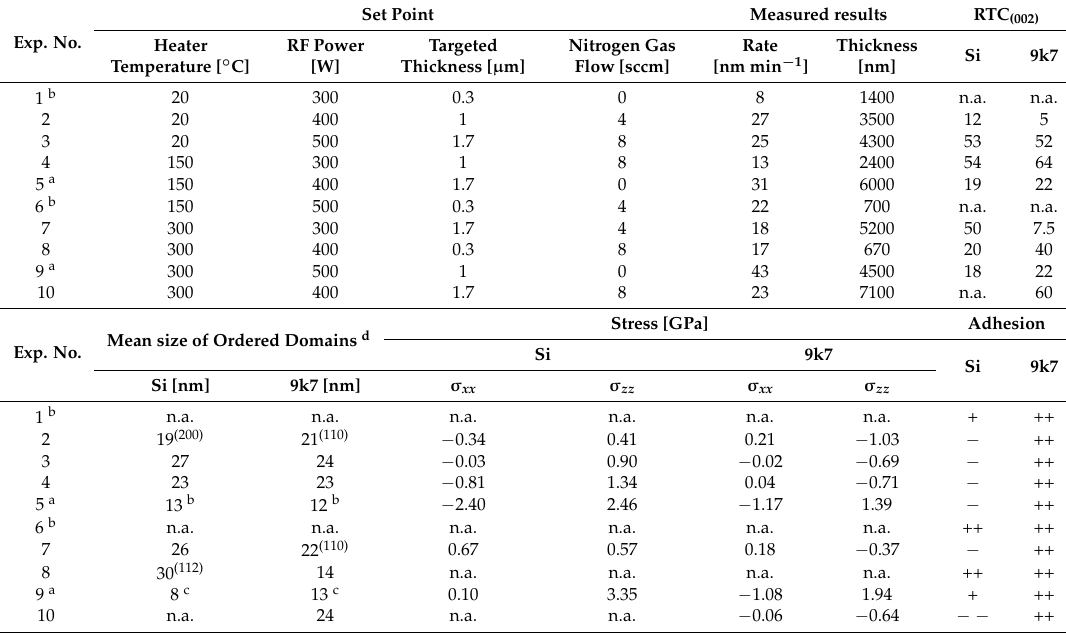
Table B1. Summary of experimental design and results. Table A1. Summary of experimental design and